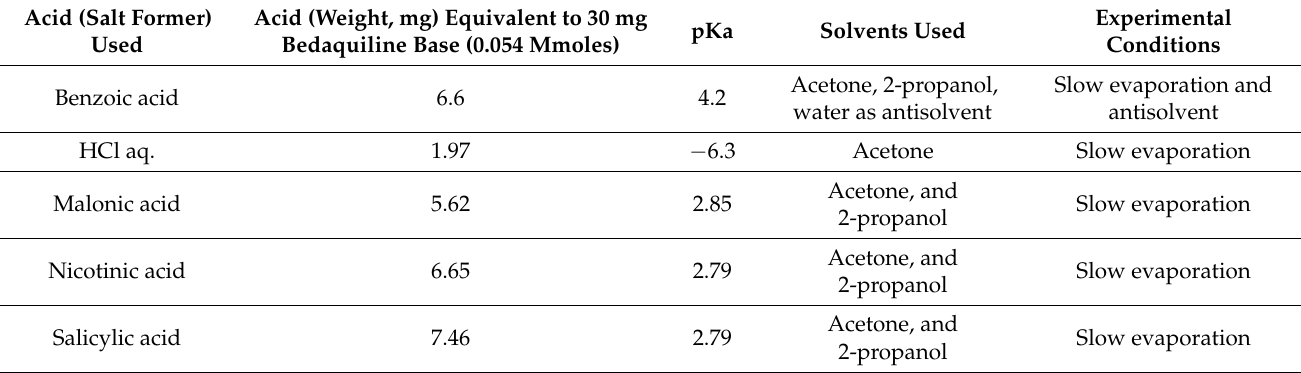
Table 1. Acids (salt formers) and equivalent weights used in the synthesis